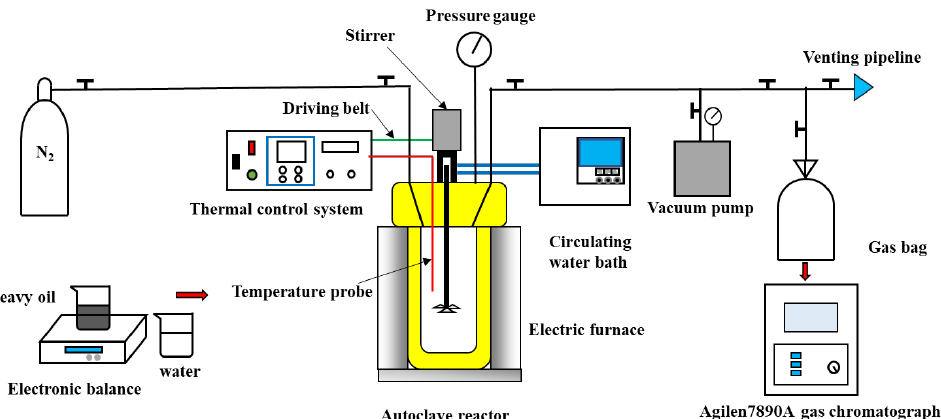
Figure 1. Schematic illustration of the experimental setup for aquathermolysis